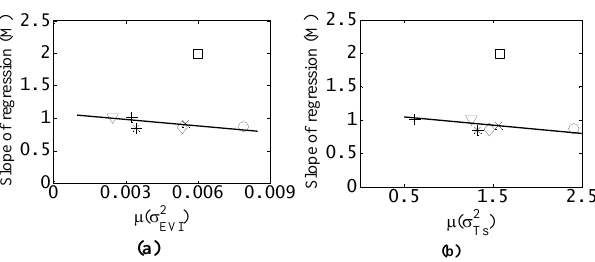
Figure 6 (a & b). Scatterplot showing the slope of regression between the observed and Figure 6. (a, b) Scatter plot showing the slope of regression estimated λE as a function of the mean variance of EVI and T S for 10 x 10 km area between the observed and estimated λE as a function of the mean surrounding the tower sites of each biome categories. Variances of individual sites falling variance of EVI and T S for a 10km × 10km area surrounding the under each biome are averaged. The solid lines are the best fit relationships (M = -23.90μ (  2 EVI ) + 1.03, R 2 = 0.37; M = -0.08μ (  2 Ts ) + 1.04, R 2 = 0.39) after removing the SAV biome tower sites of each biome categories. Variances of individual sites type. This shows M approaches unity with increasing homogeneity. falling under each biome are averaged. The solid lines are the ) + 1 . 03, R 2 = 0 . 37; best-fit relationships ( M = − 23 . 90µ (σ 2 EVI M = − 0 . 08µ (σ 2 ) + 1 . 04, R 2 = 0 . 39) after removing the SAV T S biome type. This shows M approaches unity with increasing